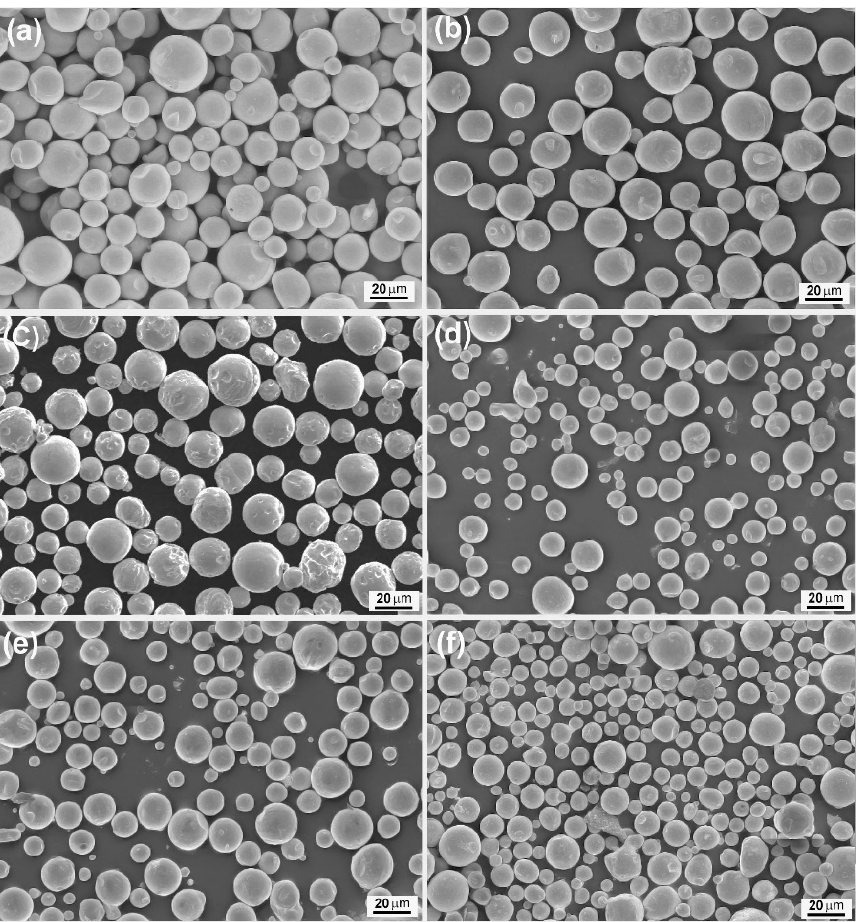
Figure 1. SEM images of metal microspheres of different chemical compositions prepared via a molten salt-based metal emulsion method:( a ) Sn, ( b ) SnCu 0.015 , ( c ) SnZn 0.04 , ( d ) SnZn 0.04 Cu 0.015 , and ( e ) SnZn 0.04 Cu 0.02 and ( f ) SnZn 0.04 Cu 0.03 .